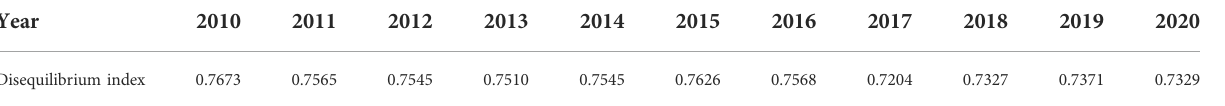
TABLE 1 Unbalanced index of industrial distribution in counties in the